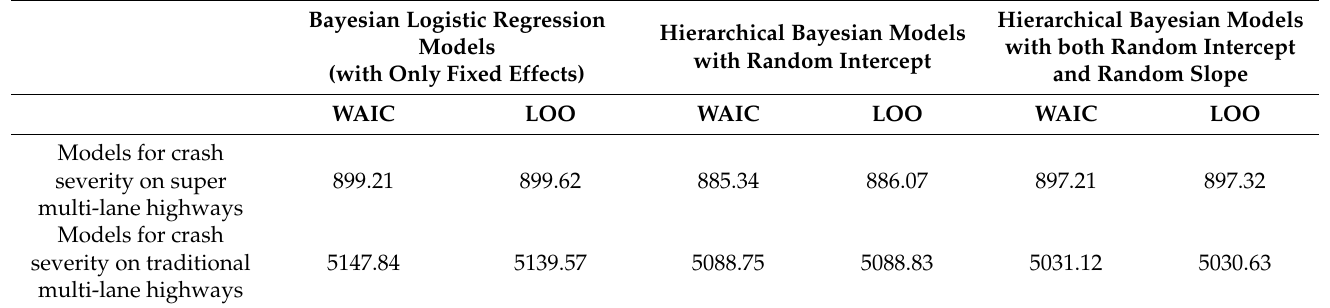
Table 2. WAIC and LOO of hierarchical Bayesian models with different